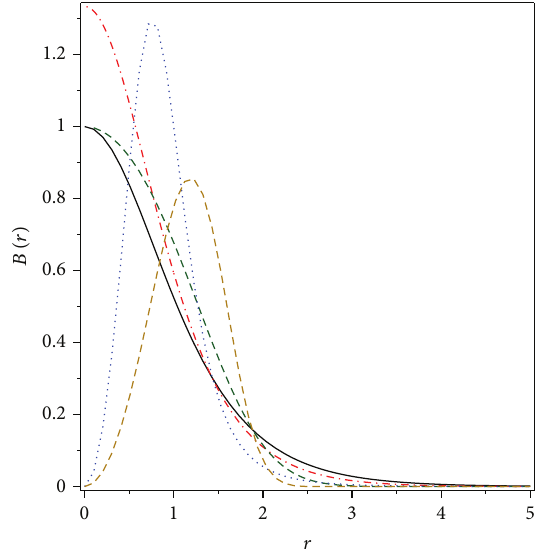
Figure 3: Solutions to 𝐵(𝑟) . Conventions as in Figure 1.